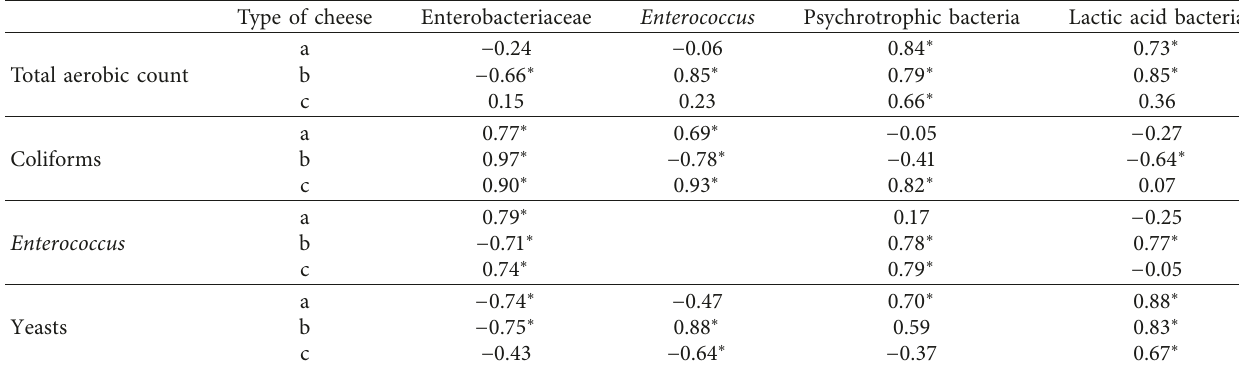
Table 2: Pearson correlation coefficients ( R ) between the microbial groups of three types of